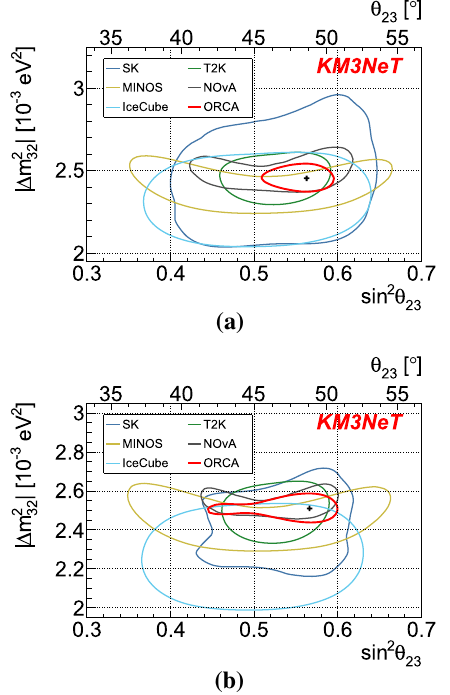
Fig. 9 a Sensitivity to NMO after 3 years of data taking, as a func- tion of the true θ 23 value, for both normal (red upward pointing trian- gles) and inverted ordering (blue downward pointing triangles) under three assumptions for the δ CP value: the world best fit point for NO, IO reported in Table 2 (plain line), 0 ◦ (dotted line) or 180 ◦ (dashed line). The coloured shaded areas represent the sensitivity that 68% of the experiment realisation would yield, according to the Asimov approach [44]. b Sensitivity to NMO as a function of data taking time for both normal (red upward pointing triangles) and inverted ordering (bluedownwardpointingtriangles)andassumingtheoscillationparam- eters reported in Table 2